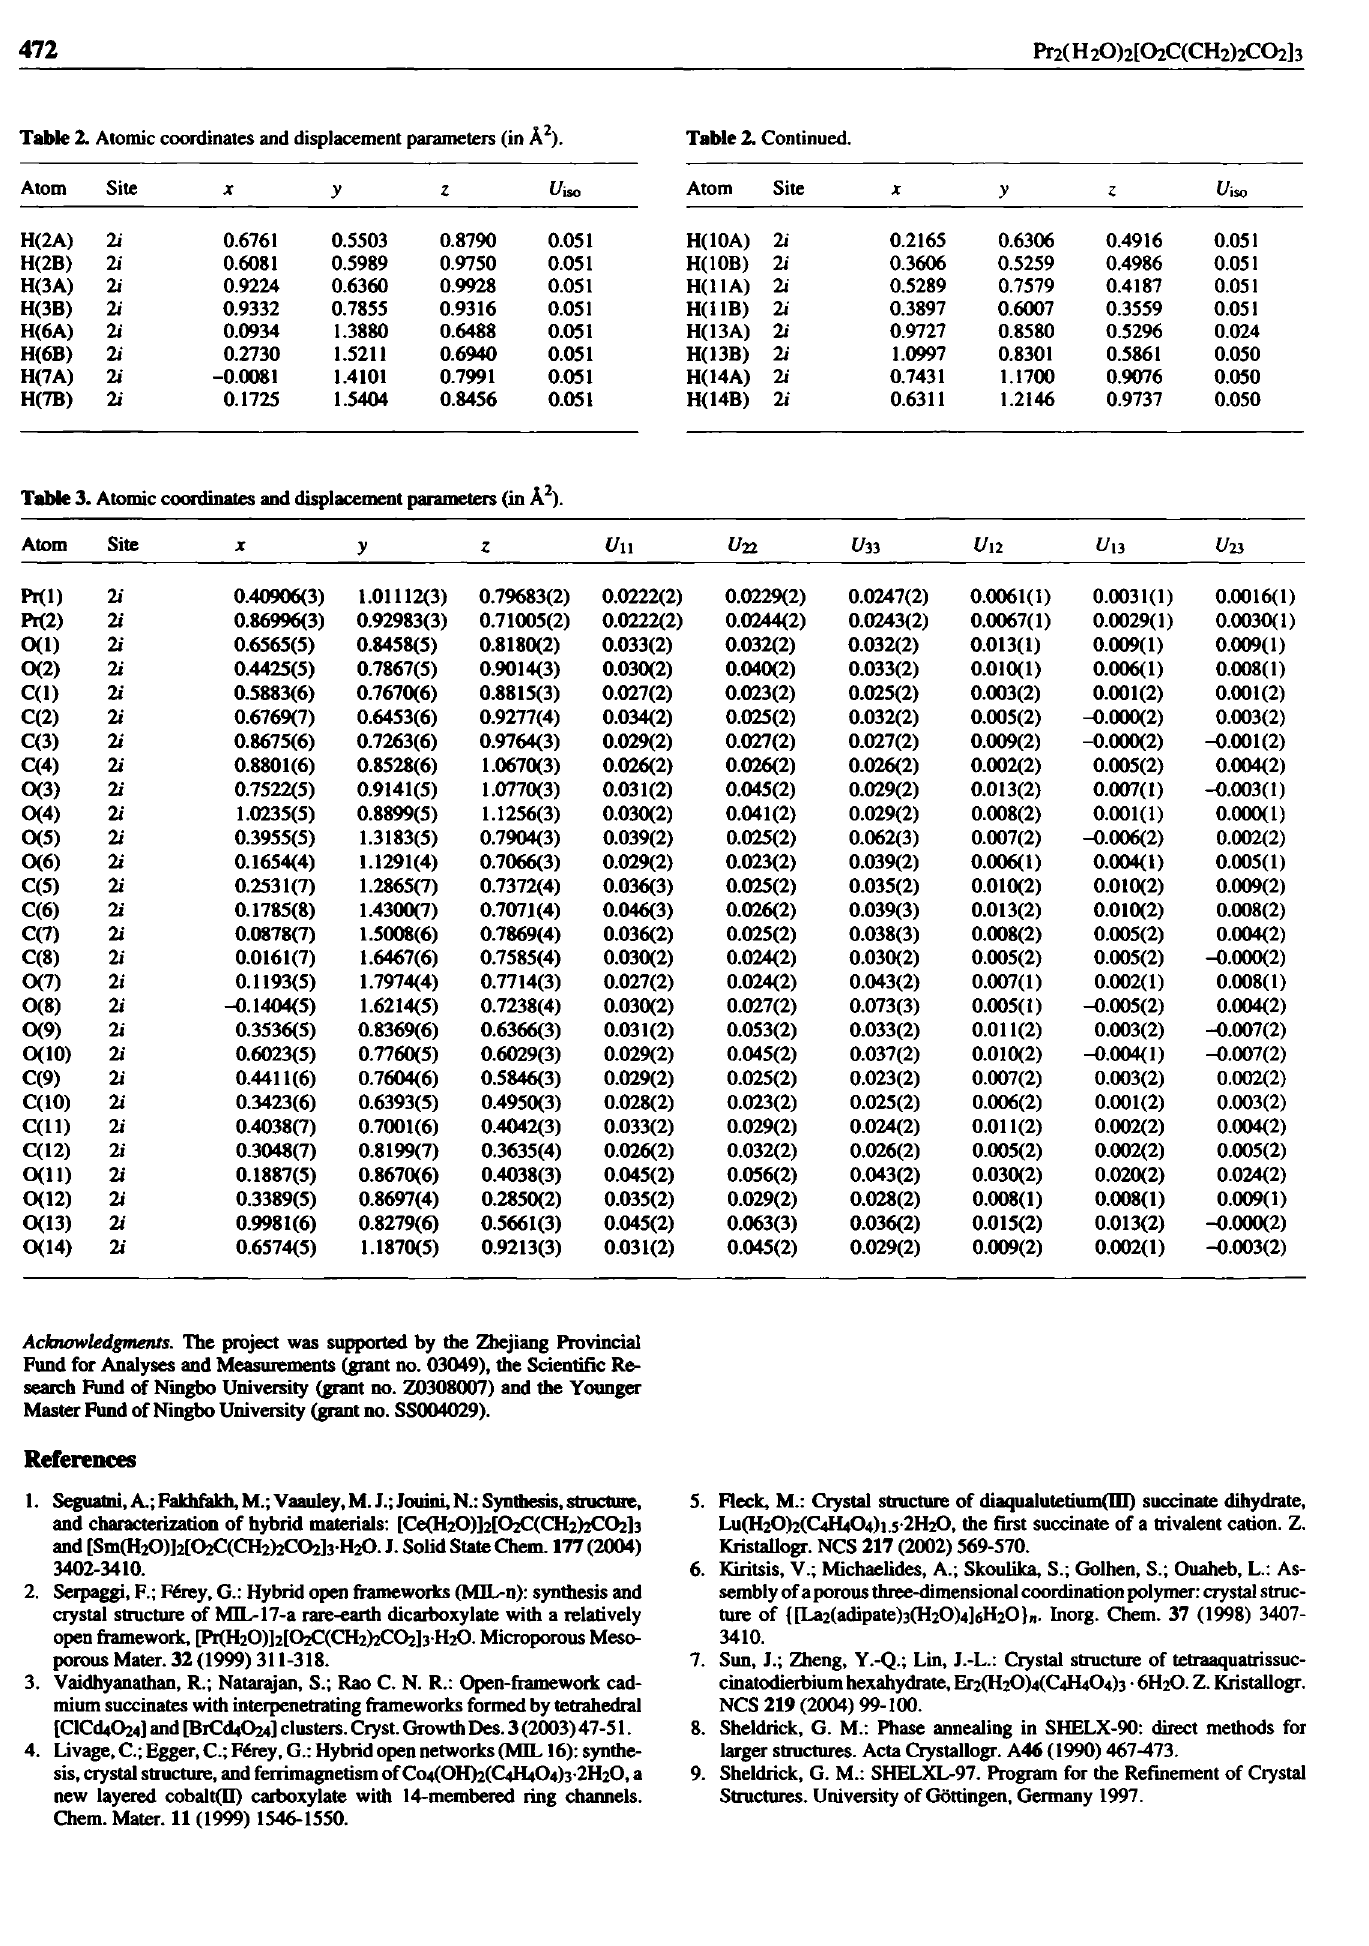
Table 2. Atomic coordinates and displacement parameters (in Ä 2 ). Table 2. Continued.